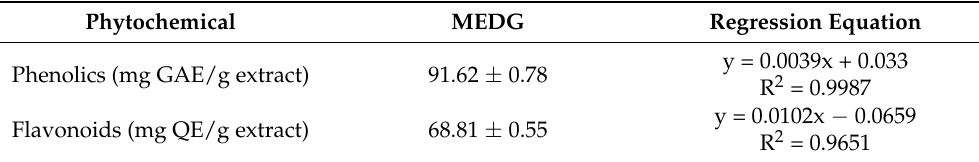
y = 0.0039x + 0.033 R 2 = 0.9987 y = 0.0102x − 0.0659 R 2 = 0.9651